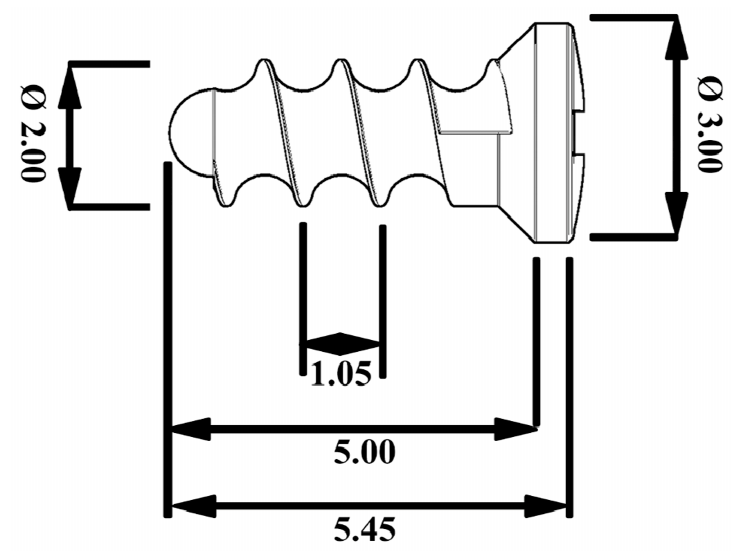
Figure 1. A schematic figure of the screws used in this study. The dimensions are listed in